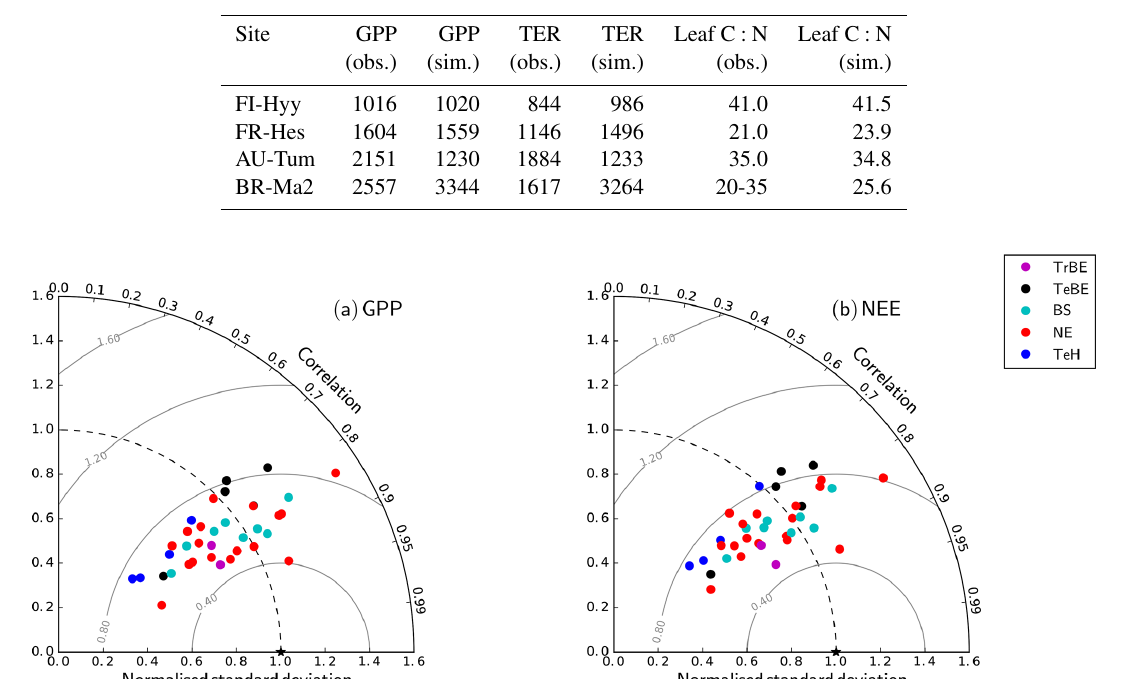
Table 2. Simulated and observed GPP (in gCm − 2 yr − 1 ), total ecosystem respiration (TER in gCm − 2 yr − 1 ), and leaf C : N (gCgN − 1 ) at four FLUXNET sites, as in Fig. 3. Values are averaged over the years where CO 2 flux observations are available.